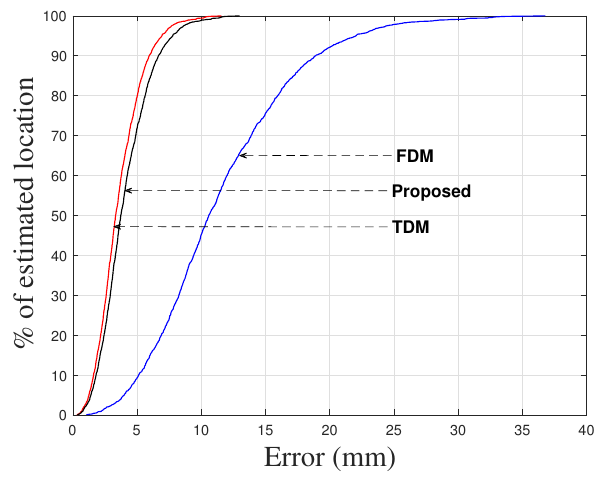
Figure 8. Cumulative absolute location errors (from experiments) of receiver obtained for the proposed, TDM and FDM techniques.